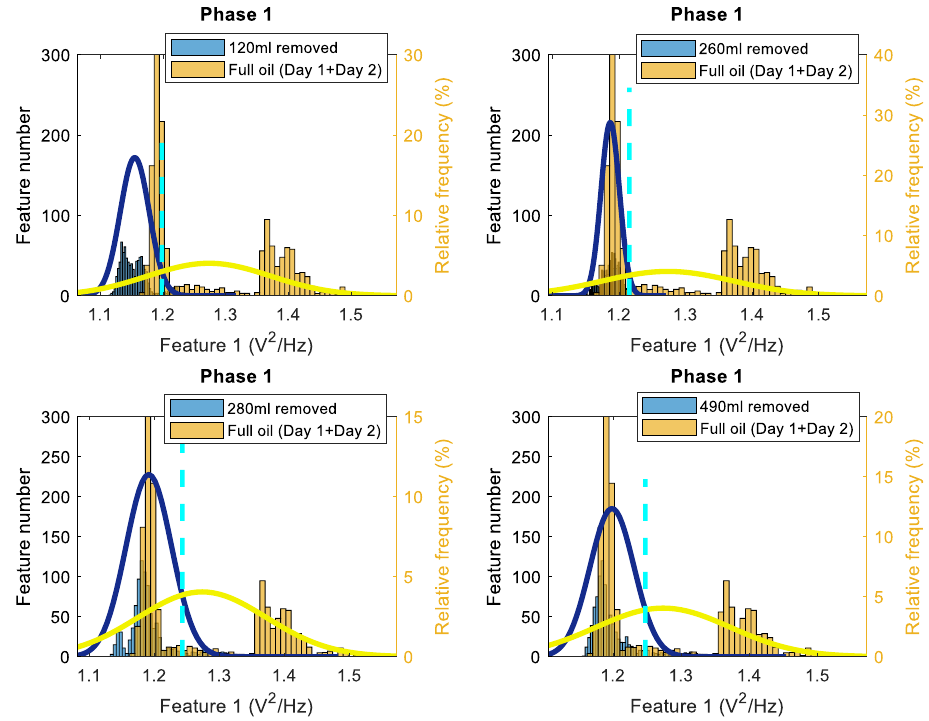
Figure A4. Histograms of Feature 1 (the first harmonic of the supply frequency) for phase 1 of the current signals, comparing the standard oil level (Day1 + Day 2) to 120 mL, 260 mL, 280 mL and 490 mL of removed oil cases.